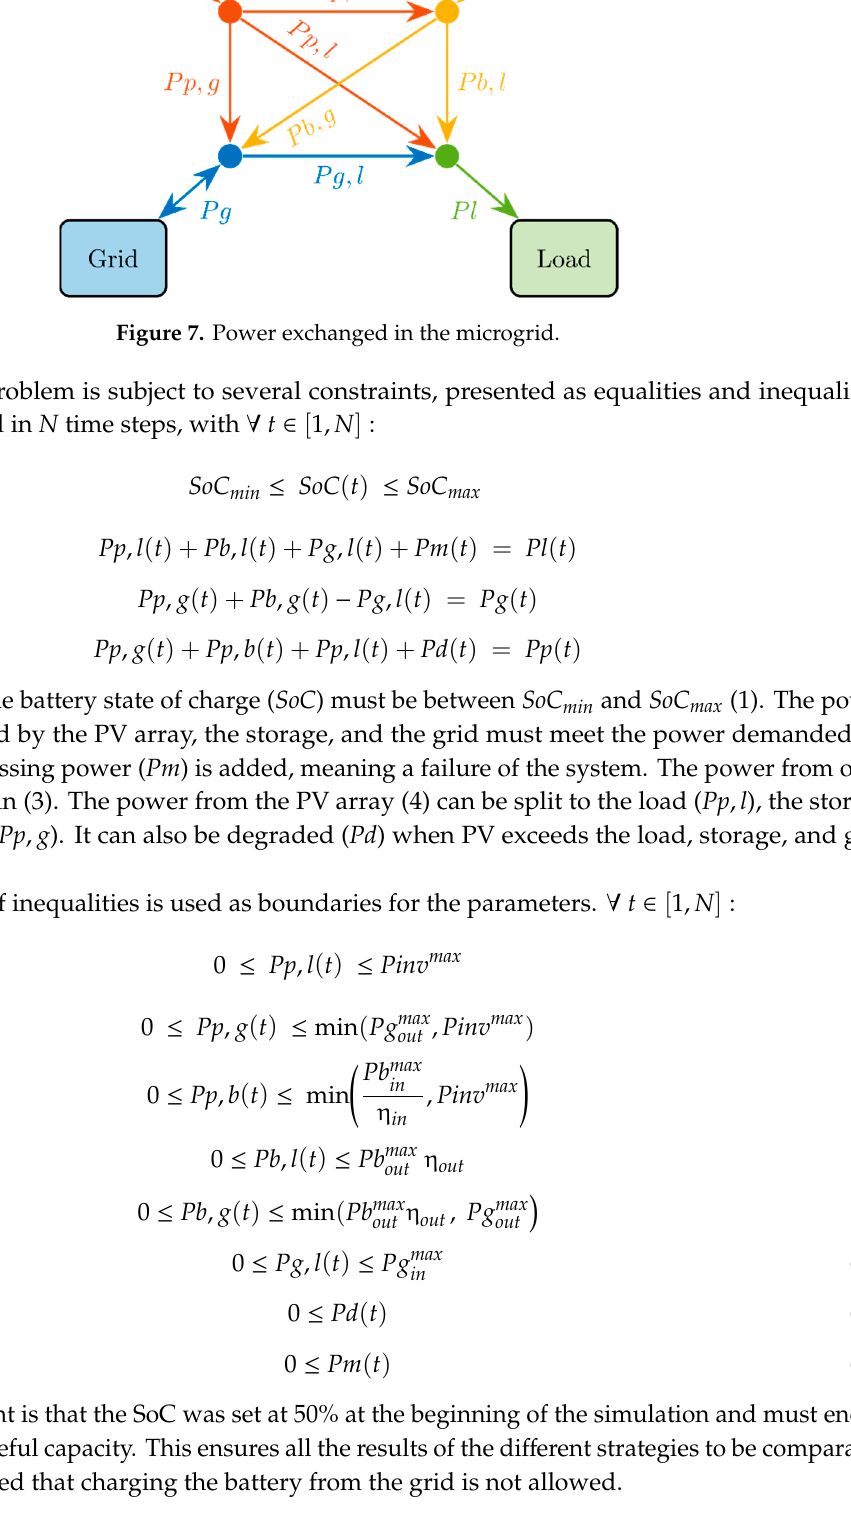
Figure 7 groups the different power flows among the different microgrid components.